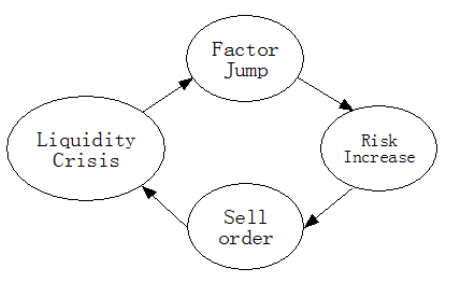
Figure 6. Cyclical Cascade of Market Events.